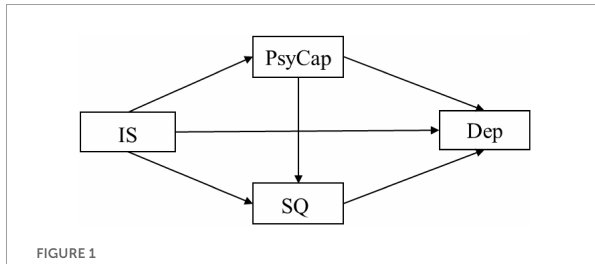
FIGURE1 The chained mediation models. In this figure, the independent variable is interpersonal sensitivity (IS), the dependent variable is depression (Dep), and the mediators are psychological capital (PsyCap) and sleep quality (SQ).